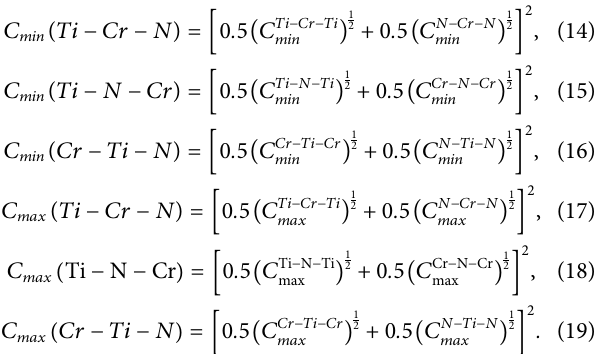
re fl ect the screening degree of the third atom ( C ) on the interaction between two neighboring A and B atoms of various types. For the Ti – Cr – N ternary system, the parameters are Due to the dif fi culty in acquiring enough data to uniquely con fi rm the ternary PPs, the method for developing the interaction potential parameters of the binary system is